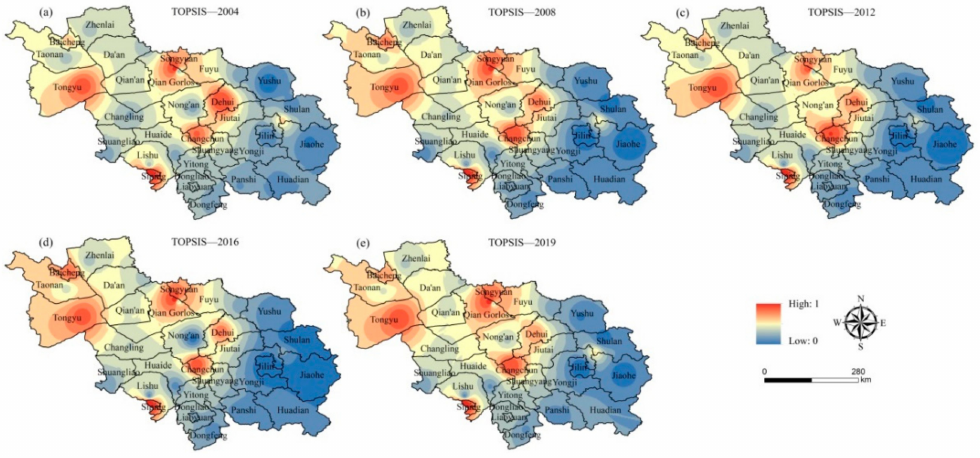
Figure 6. Spatial distribution of drought risk based on the TOPSIS model.